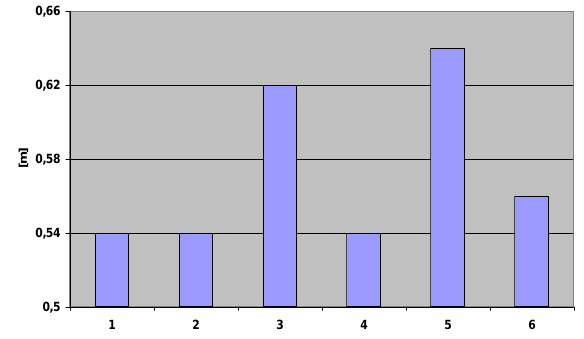
Figure 6. Planimetric errors with p=0.95. It means: 1=0.5(a+b),